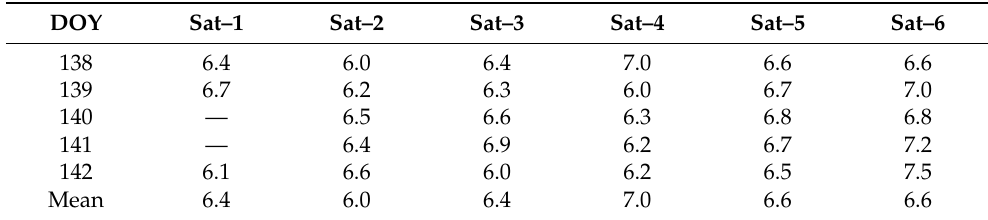
Table 5. Statistical results of RMS of carrier-phase residuals